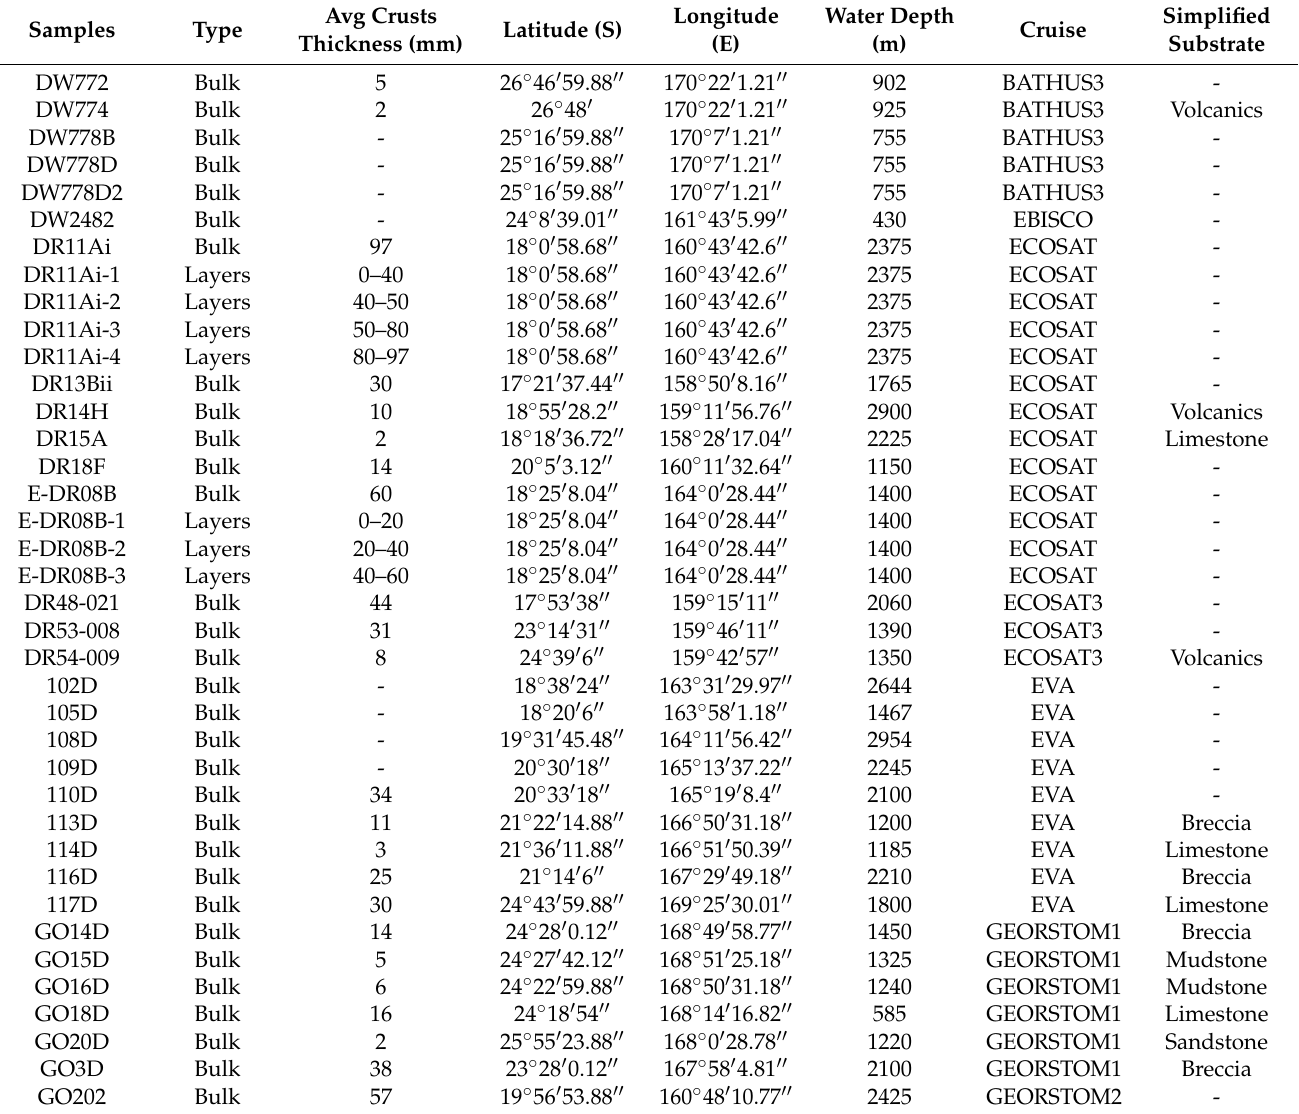
Table 1. Sample information for selected deposits ( n =